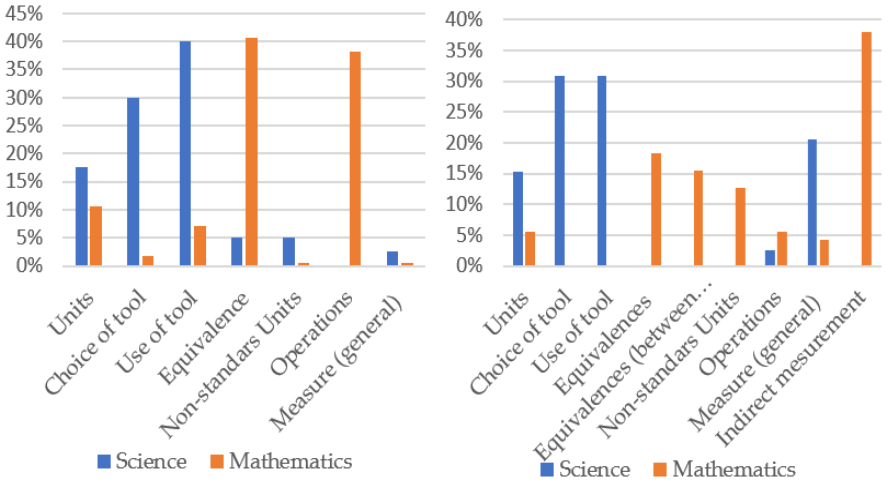
Figure 3. Measurement skills for ( left ) mass and ( right ) volume.